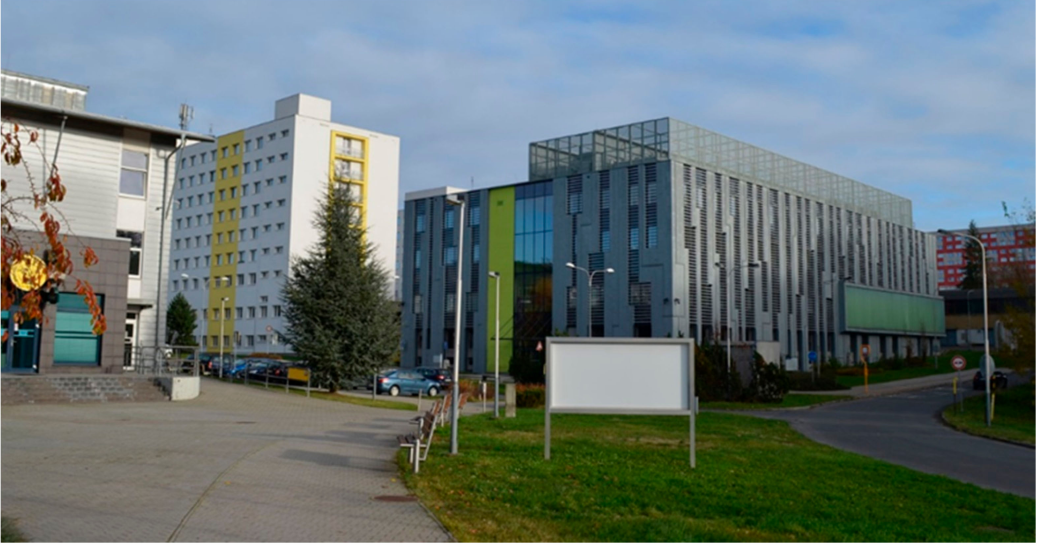
Figure 10. Hub I: selected buildings hosting ICT firms, location